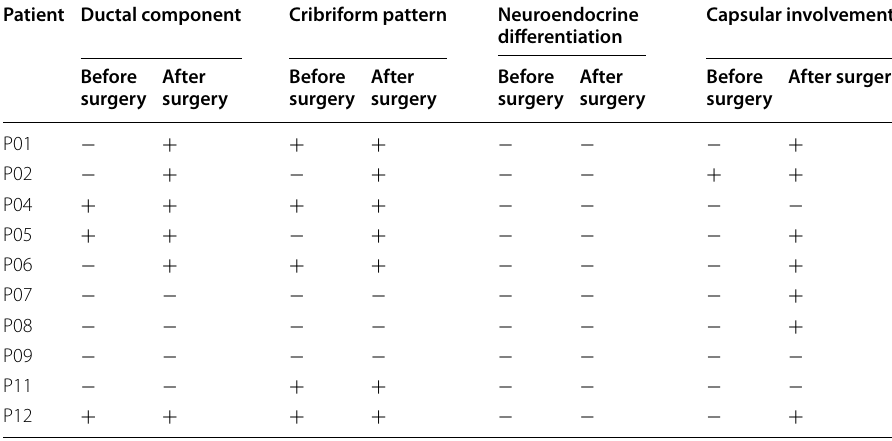
Table 2 Histopathology before and after surgery Patient Ductal component